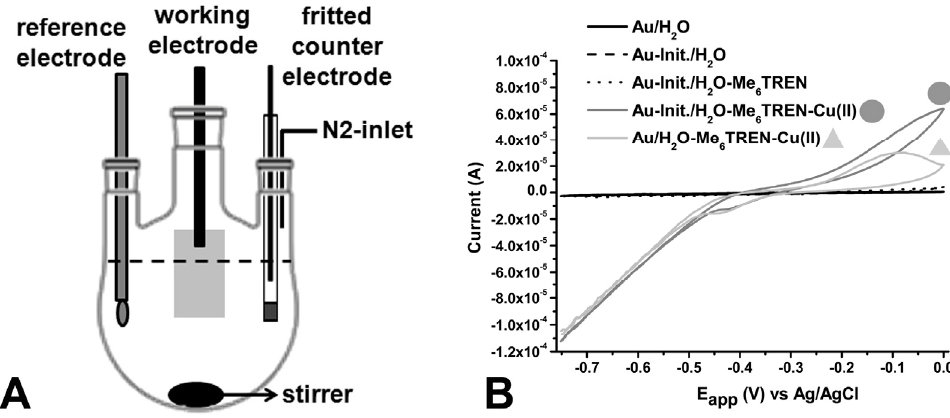
Figure 1. ( A ) Schematic representation of the reaction setup; ( B ) Cyclic voltammograms of flat gold-electrodes non-covered ( — , black ) and modified with the ATRP-initiator (Init.) ( – – ) in degassed MilliQ-water and modified gold-electrode in the presence of 1 mM TREN ( - - - ), Cu(II)Br /Me TREN (1:1) ( — , dark grey , ● ) and Cu(II)Br /Me TREN Me 6 2 6 2 6 (1:1) on unmodified gold-electrode ( — , light grey , ▲ ) recorded at scan speed ( v ) v = 0.02 V·s − 1 ; ( C ) Cyclic voltammograms of flat unmodified gold-electrodes in degassed MilliQ-water in the presence of 1mM Cu(II)Br /Me TREN (1:1) recorded at v = 0.02 V·s − 1 . 2 6 Arrows indicate the direction to how changes in signals progress with each cycle; and ( D ) Cyclic voltammograms of flat with initiator modified gold-electrodes in degassed /Me TREN (1:1) recorded at v = 0.02 V·s − 1 . MilliQ-water in the presence of 1 mM Cu(II)Br 2 6 The cyclic voltammogram does not display any changes over multiple